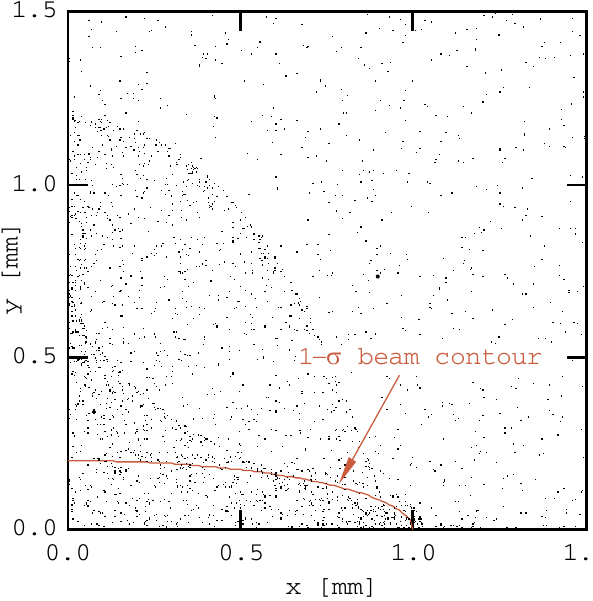
FIG. 61. (Color) Simulated electron distribution for the PEP-II LER pumping straight chamber just after the tail of a bunch has passed [86].